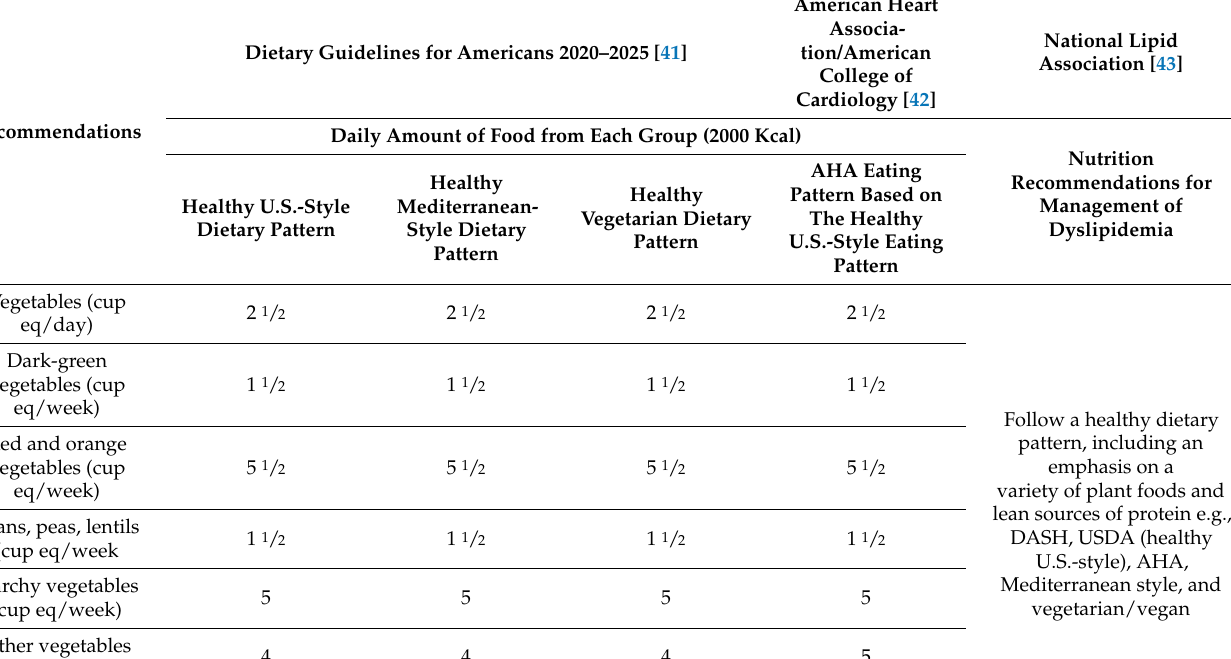
Table 2. Dietary recommendations for general health and CVD prevention and management.